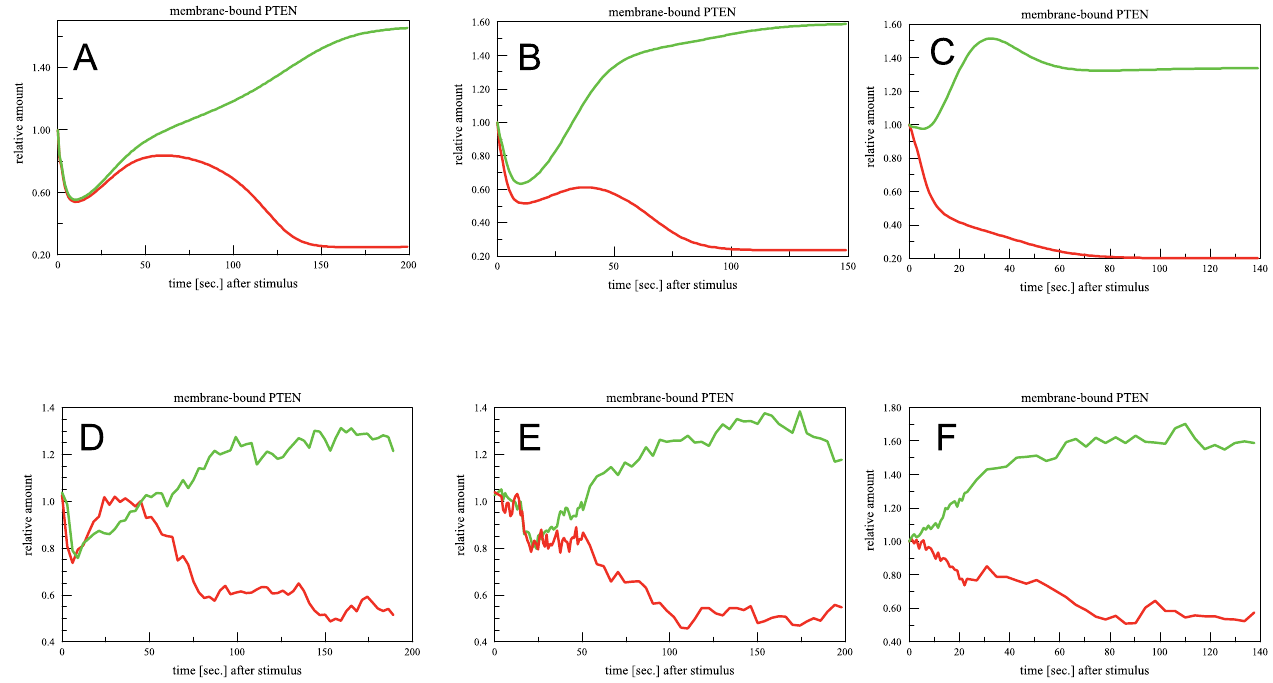
Figure 6. Correspondence in Time and Space between the Predicted and Measured Changes in Membrane-Bound PTEN at the Front and Back of the Cells Exposed to cAMP Gradients These dose-dependent dynamics of PTEN were produced by the simulation after the dynamics of PIP 3 for one cAMP concentration (100 nM) had been used to adjust model parameters. (A), (B), and (C) are simulated responses. (D), (E), and (F) are experimental measurements based on GFP-PTEN analysis in single cells exposed to gradients with a mean cAMP concentration of 1 l mol, 100 nmol, and 10 nmol. See Figure S7 for details on the full dataset of experimental replicates. DOI: